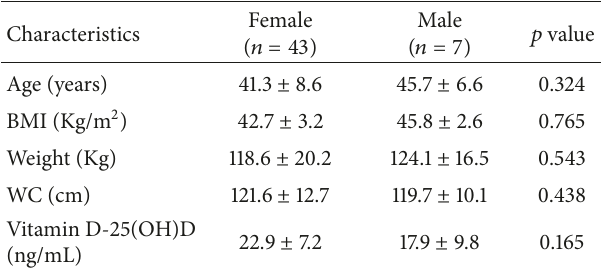
Table 1: Mean of age, characteristics anthropometric, and concen- tration of vitamin D according to gender of the sample ( 𝑛 = 50 ).